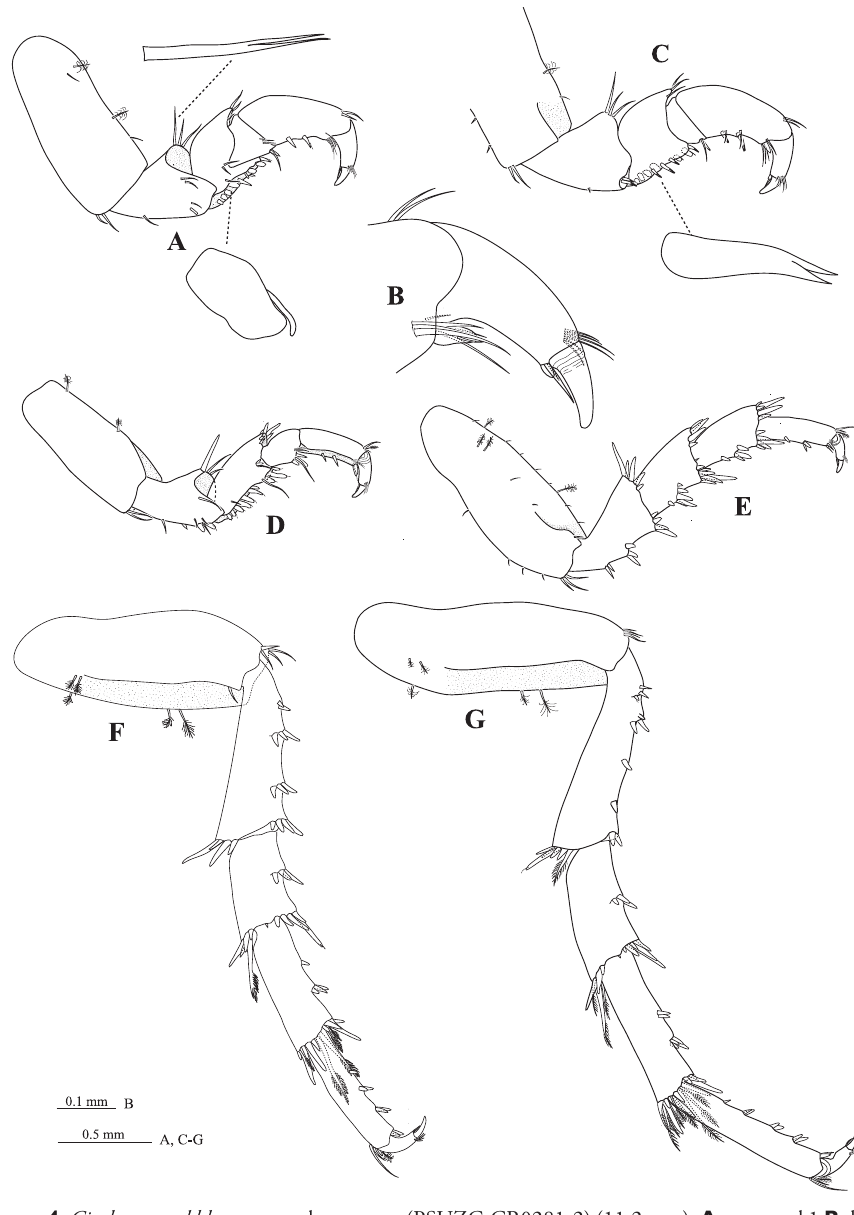
Figure 4. Cirolana songkhla sp. n., male paratype (PSUZC-CR0281-2) (11.2 mm). A pereopod 1 B dac- tylus of pereopod 1 C mesial view, pereopod 1 D pereopod 2 e pereopod 4 F pereopod 6 G pereopod 7. Penes (Figure 2I, J) medially united low papillae. Pleopod 1 (Figure 5A) exopod 1.3 times as long as wide, lateral margin weakly convex, distally broadly rounded, mesial margin weakly convex, with ~35 PMS